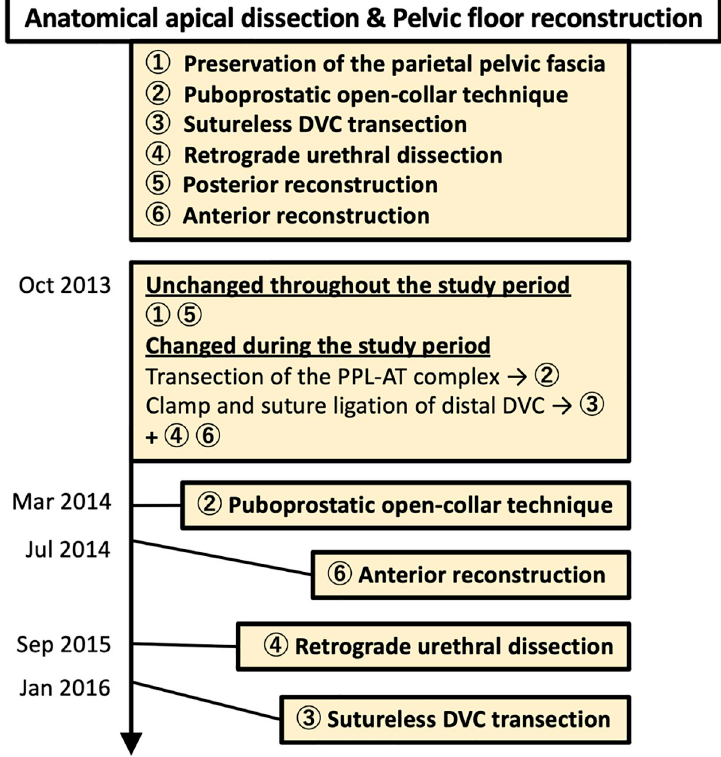
Fig 2. Modifications of anatomical apical dissection and pelvic floor reconstruction during the study period. Procedures ① and ⑤ remained unchanged throughout the study period. Transection of the puboprostatic ligament (PPL)-arcus tendinous (AT) complex, and distal clamp and suture ligation of the dorsal vein complex (DVC) were replaced by procedures ② and ③ , respectively. Procedures ④ and ⑥ were newly introduced during the study period.